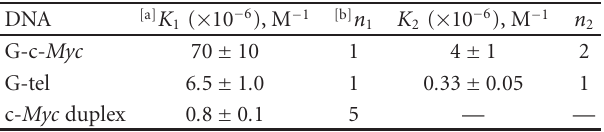
Table 1: Binding parameters of AIC:DNA complexes.